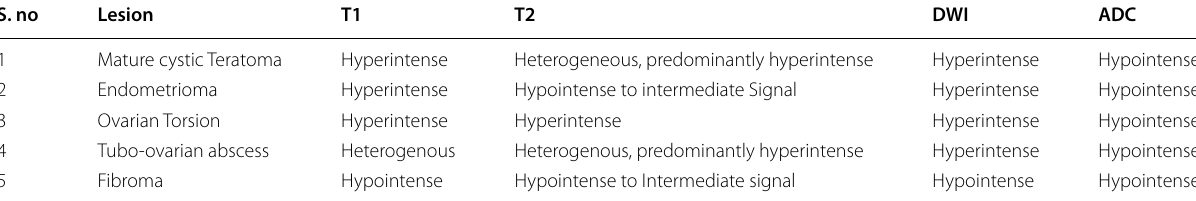
Table 1 MRI features of various adnexal